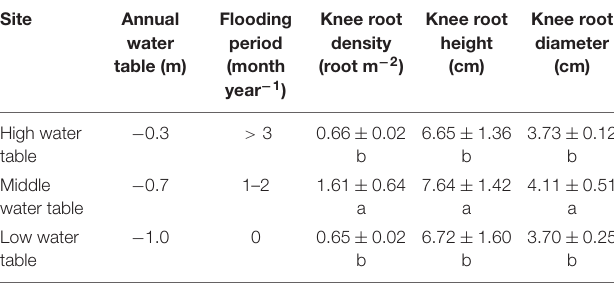
TABLE 1 | Number and size of knee roots of Taxodium ascendens at different water table